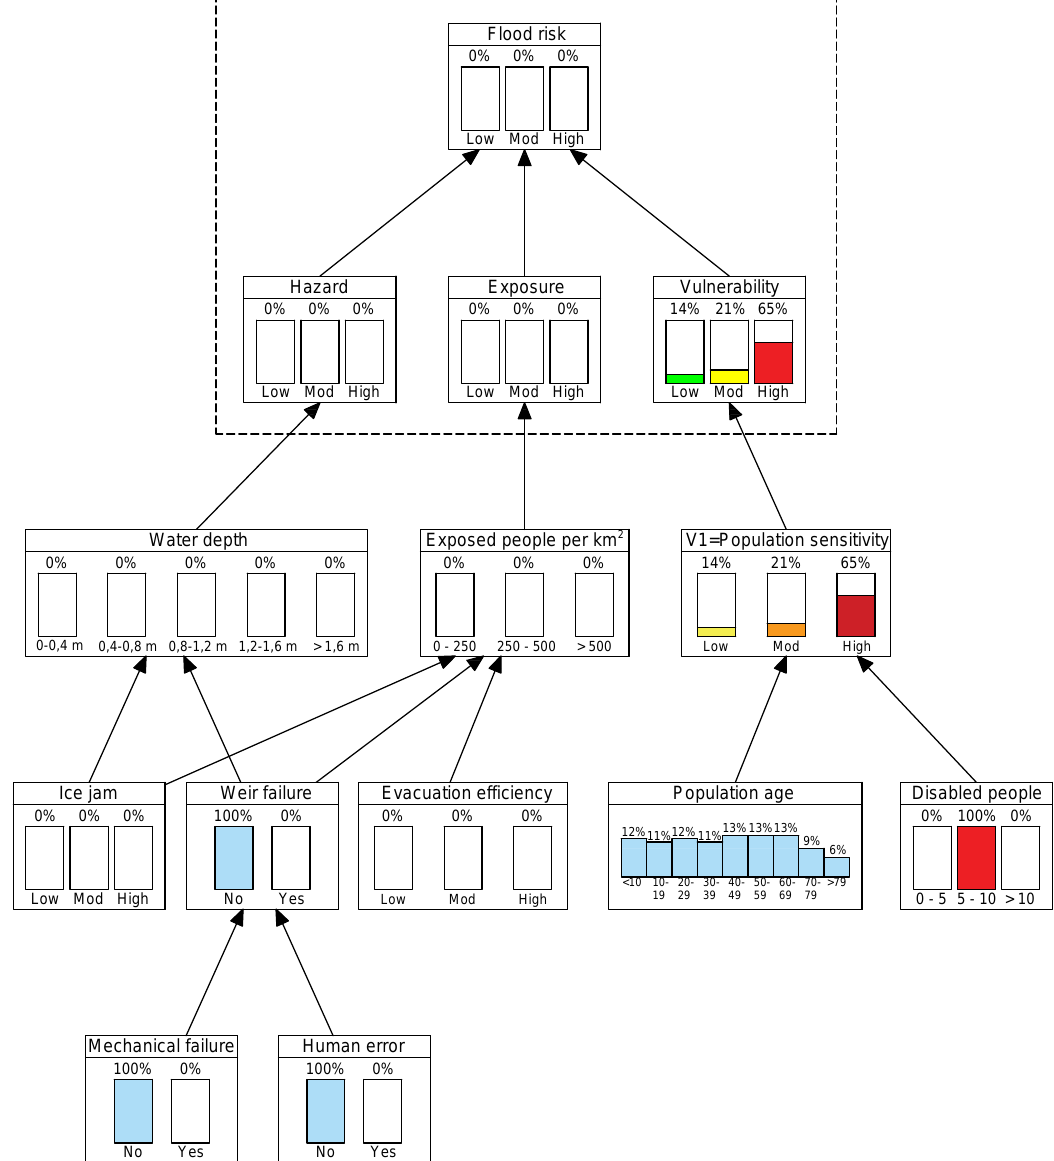
Figure 13. Updated Bayesian network model for Slavonski Brod.